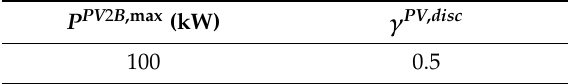
Table A2. ESS Table A2. ESS data.